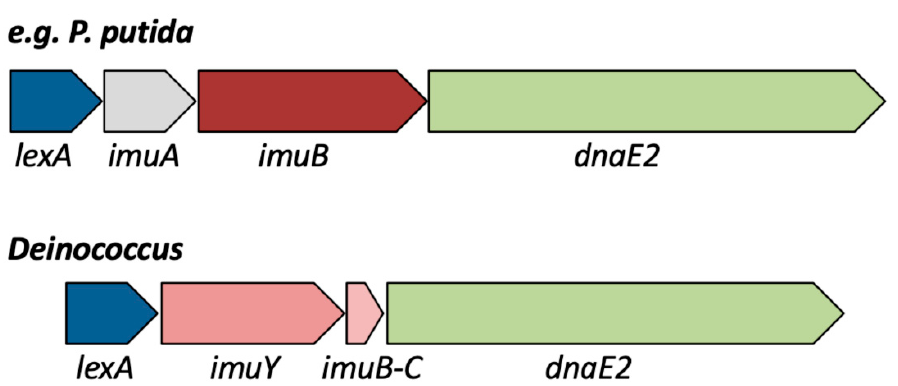
Figure 1. Schematic representation of the lexA-imuA-imuB-dnaE2 and lexA-imuY-imuB-C-dnaE2 mutagenesis cassettes. The operon encoding LexA, ImuA, ImuB and DnaE2 is present in bacterial species such as Pseudomonas putida , Pseudomonas fluorescens , Pseudomonas syringae , Xanthomonas campestris , Dechloromonas aromatica , Methylococcus capsulatus , and Acidithiobacillus ferrooxidans . The operon encoding LexA, ImuY, ImuB-C and DnaE2 is present in at least 20 Deinococcus species, including D. deserti , D. ficus , D. peraridilitoris , D. marmoris , D. koreensis and D. grandis . For D. deserti , the locus tags are Deide_1p01870 ( lexA ), Deide_1p01880 ( imuY ), Deide_1p01890 ( imuB-C ) and Deide_1p01900 ( dnaE2 ).